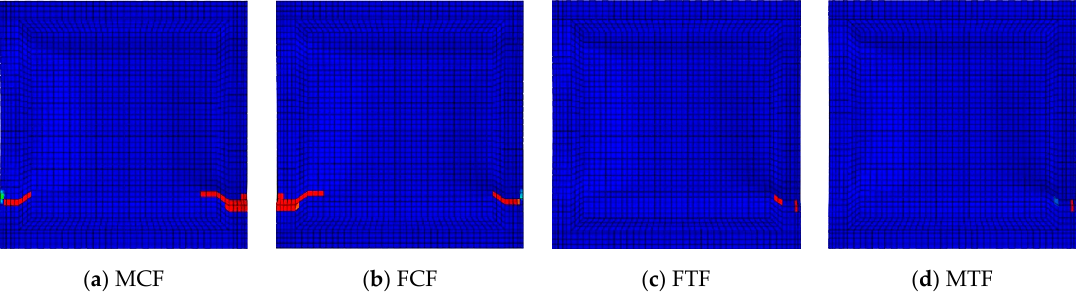
Figure 20. Failure modes of outer skin in the CD0 Model. ( a ) Matrix compressive failure (MCF); ( b ) Fiber compressive failure (FCF); ( c ) Fiber tensile failure (FTF); ( d ) Matrix tensile failure (MTF).